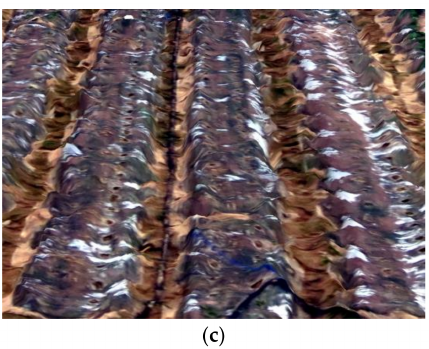
Figure 9. 3D views of digital surface models (DSMs) of ( a ) Chinese cabbage; ( b ) white radish and ( c ) a digital terrain model (DTM) created using structure from motion (SfM) processing.